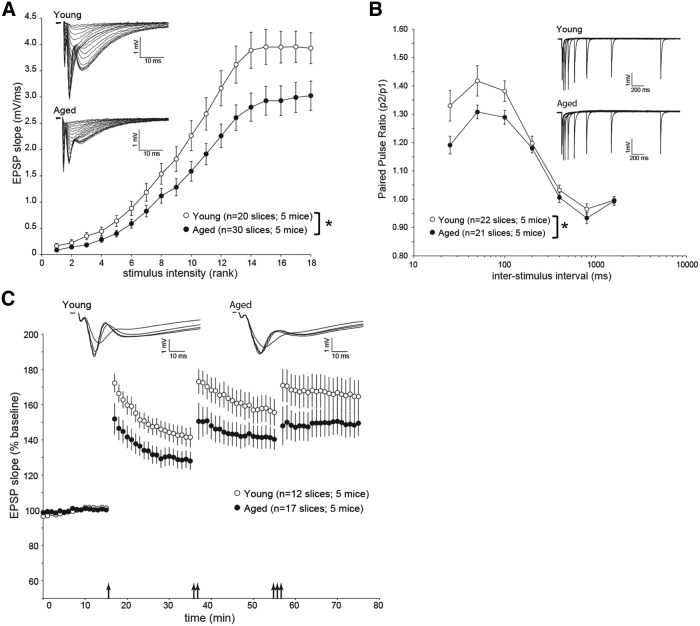
Age-dependent changes in electrophysiological measures of synaptic function in hippocampal area CA1. A, Field EPSPs measured in CA1 in response to stimulation of the Schaffer collateral pathway were reduced in aged mice. Initial EPSP slope is shown in response to increasing stimulation intensity (up to 1 mA, logarithmically spaced increments). Example traces from young and aged mice are shown in the inset. B, The PPR [EPSP slope in response to the second pulse (p2) divided by the EPSP slope in response to the first pulse (p1)] is shown as a function of interstimulus interval. Example traces from young and aged mice are shown in the inset. PPR values >1 reflect PPF. C, The EPSP slope normalized to baseline is shown during the course of the experiment. LTP was induced using TBS. The number of arrows corresponds to the number of TBS bouts. Example traces from young and aged mice are shown in the inset. Values are expressed as the mean ± SEM. PPF, Paired-pulse facilitation. *p < 0.05.